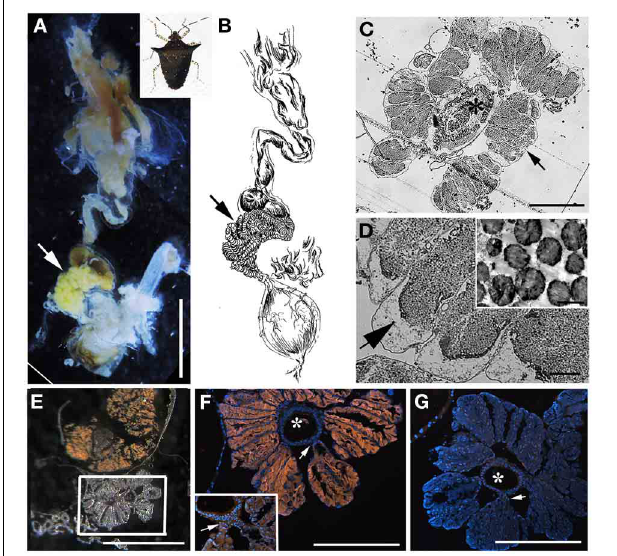
FIGURE 4 | Bacteria associated with Sibaria englemani . (A) Dissected digestive system, arrows indicate symbiont-bearing tissue. Scale, 2mm (B) Line drawing of the digestive system (C) Light microscopy image of a transverse section showing bacteria-containing crypts within the midgut ceca (arrow). An arrow indicates symbiont-bearing tissue and an asterisk shows the main gut cavity. Scale, 100 µ m. (D) Transmission electron microscopy of bacteria-like cells within the midgut ceca. Scale, 20 µ m. Symbiont separation from the outer tissue membrane, as denoted by the arrow, may be an artifact of fixation. Inset shows bacteria as irregular cocci (Scale, 2 µ m). (E) A transverse section through the midgut ceca. The non-symbiont containing sac-like midgut region (M3), as described in Futahashi et al. (2013), is shown at top. The square denotes the region shown in (F,G) . Scale, 2mm (F) Fluorescence in situ hybridization (FISH) microscopy of the same region as shown in (E) , hybridized with the Sibaria -symbiont specific probe labeled with Cy3, shown in orange, and counter-stained with DAPI, shown in blue. An asterisk shows the main gut cavity. Scale, 500 µ m. Inset shows connections between main gut cavity and crypts (arrow). (G) FISH microscopy of the region shown in (E,F) , as a negative control using an Epsilonproteobacteria-specific probe (EP404, Macalady et al., 2006), labeled with Cy3, shown in orange, and counter-stained with DAPI, shown in blue. Scale, 500 µ